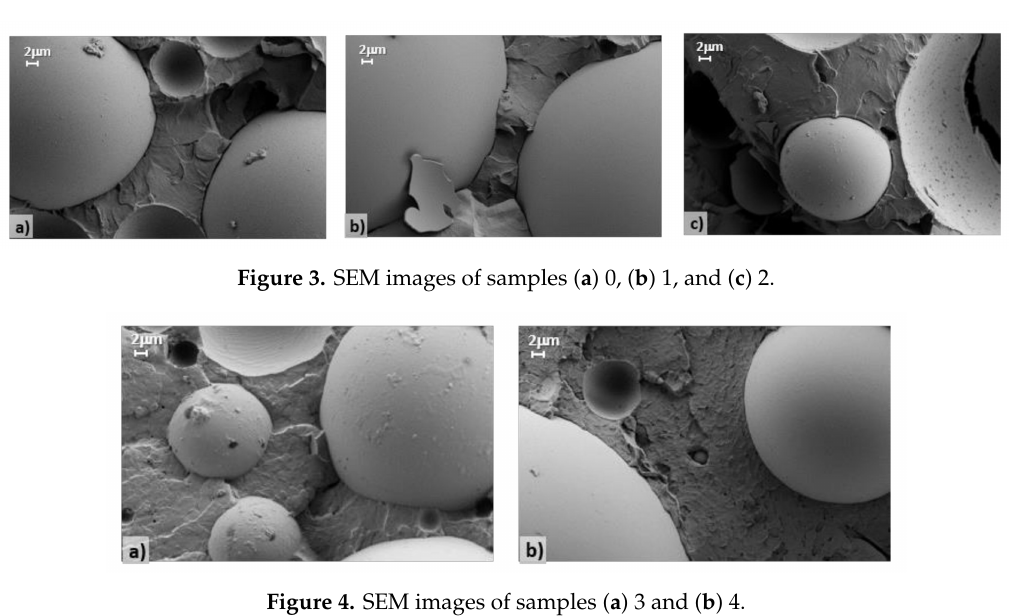
Figure 4. SEM images of samples ( a ) 3 and ( b )